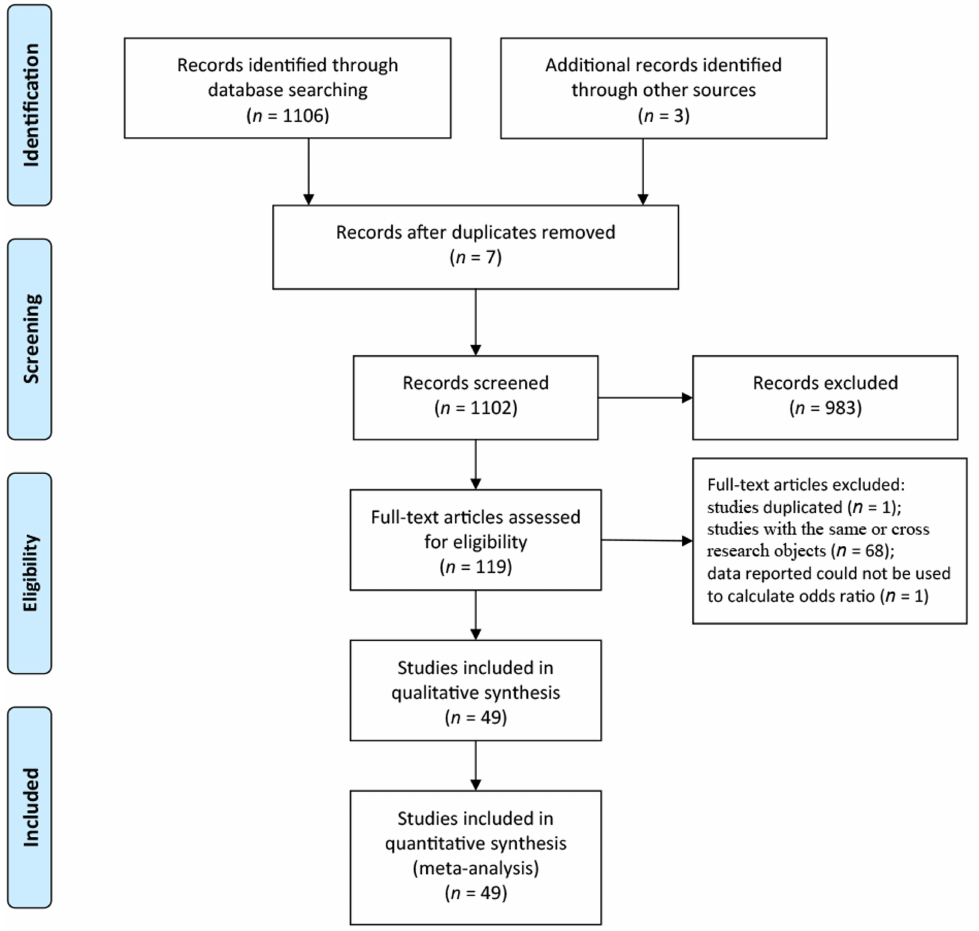
Figure 1. A flow chart of the studies selection